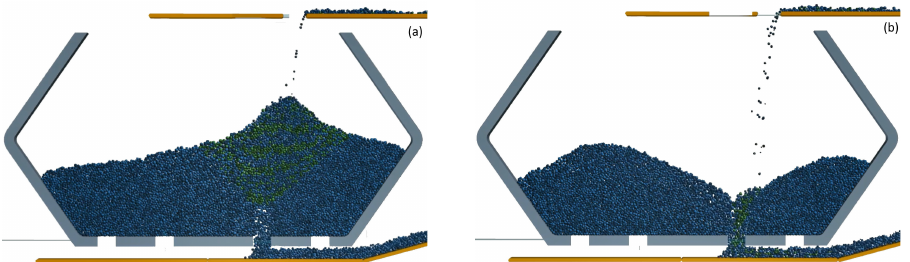
Figure 6. The storage asset at two different pile states, pointy ( a ) and depleted ( b ). Blue and green particles have hardness values of 1 and 2,